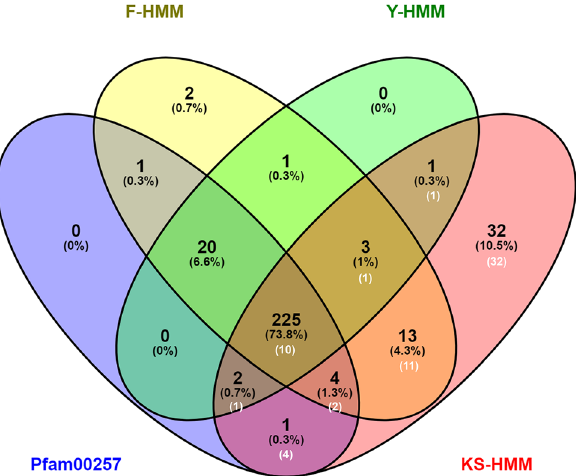
Figure 1. DHNs identified in Viridiplantae genomes by different HMM profiles. Sequences retrieved from species genomes using F-HMM, Y-HMM, KS-HMM profiles constructed in this study and Pfam00257 the Pfam profile for dehydrin family proteins are displayed as a Venn diagram. White numbers indicate the number of KS-DHNs present in each subset. Note that most KS-DHNs are not recovered using